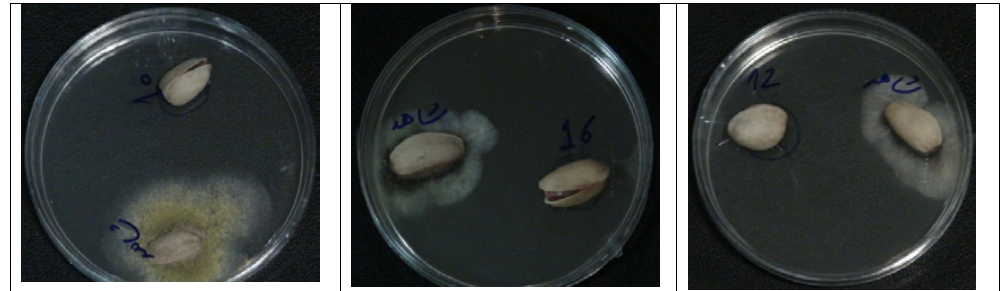
Fig. 6. Antimicrobial activity of coated PLA nano-composites containing ZnO 1%, 3% and 5% (a, b and d) and uncoated pistachios against Aspergillus parasiticus (PTCC5018)